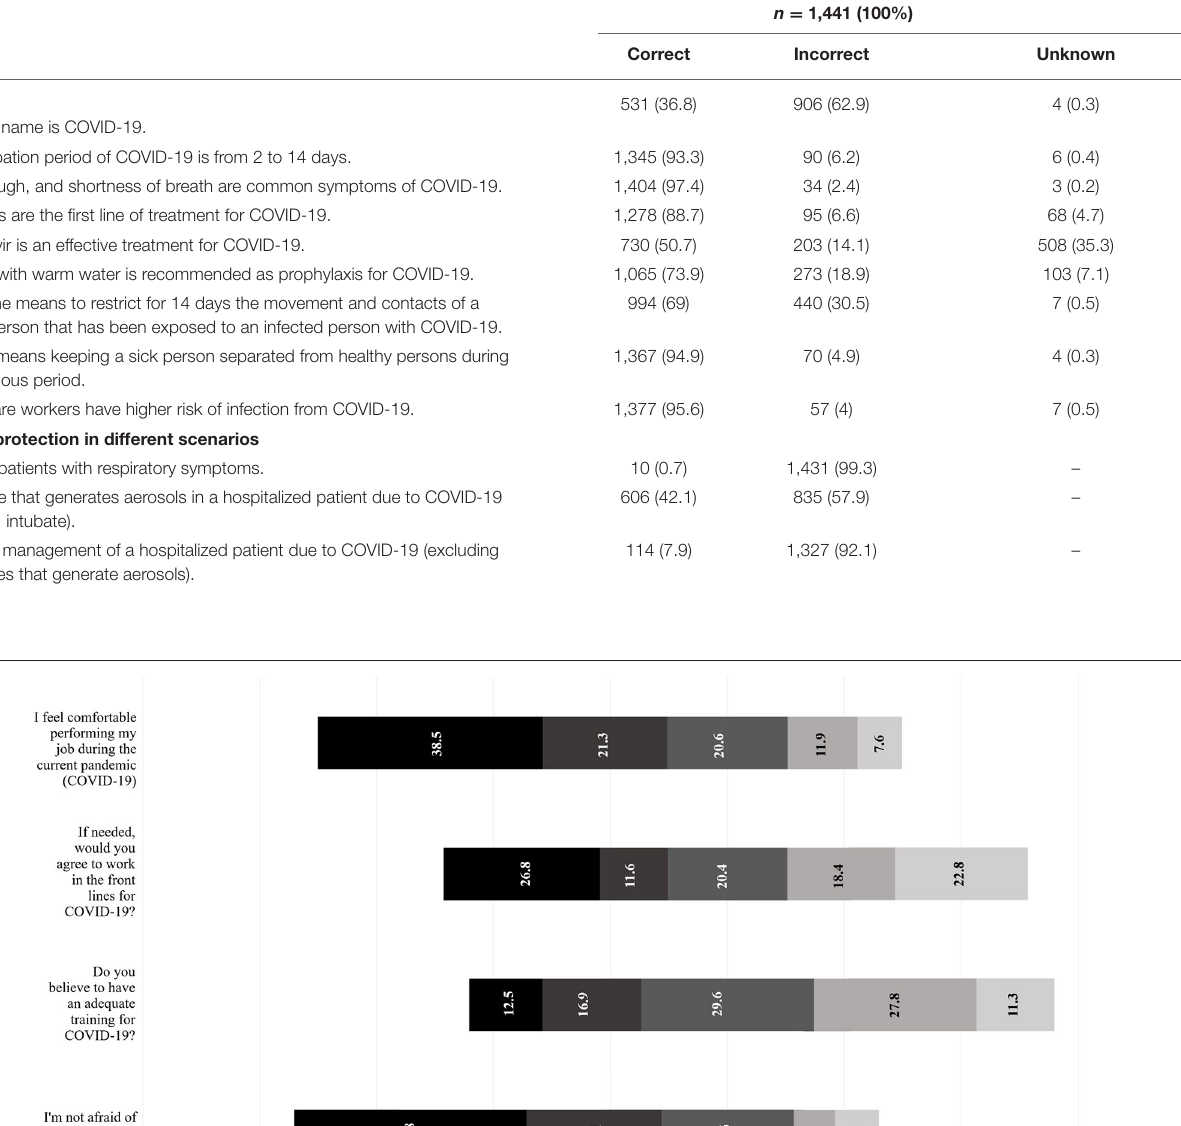
TABLE 2 | Healthcare workers’ knowledge related to COVID-19. Knowledge